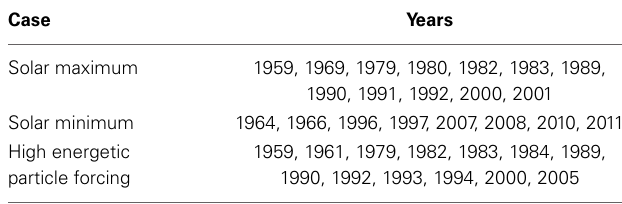
Table 1 | Years included in the